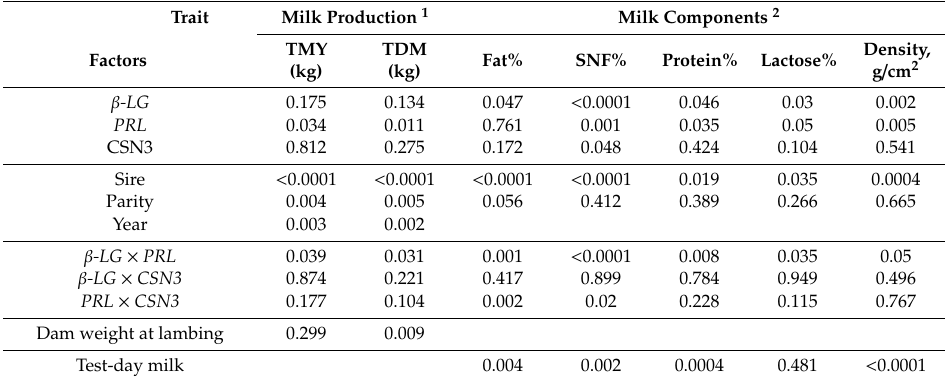
Table 4. p -values for milk production and composition traits.